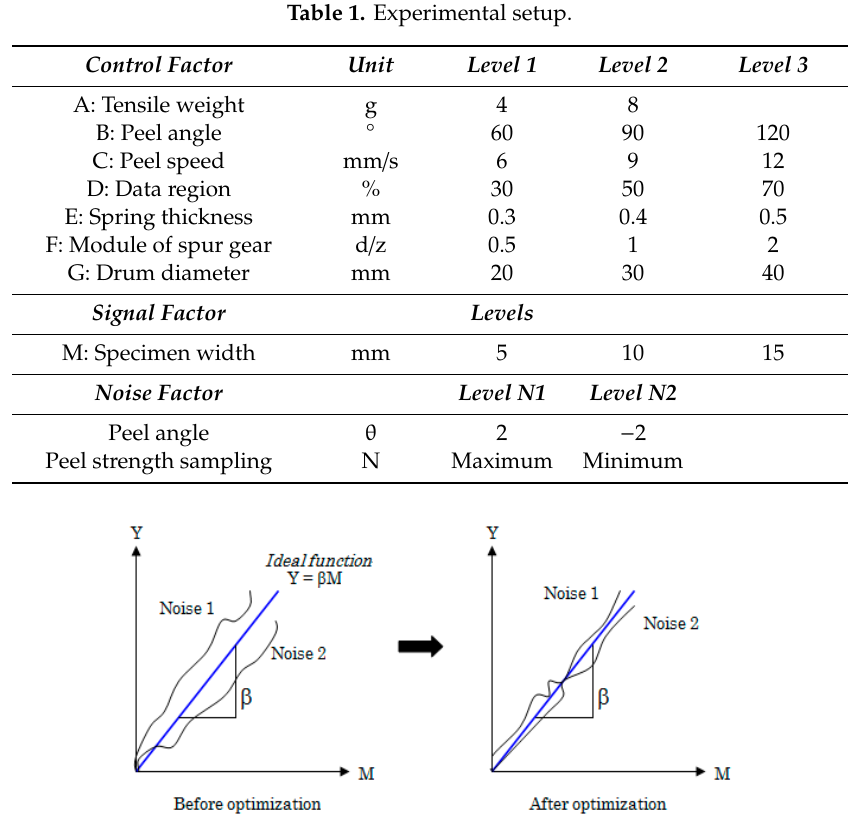
Figure 8. Variability improvement after optimization.